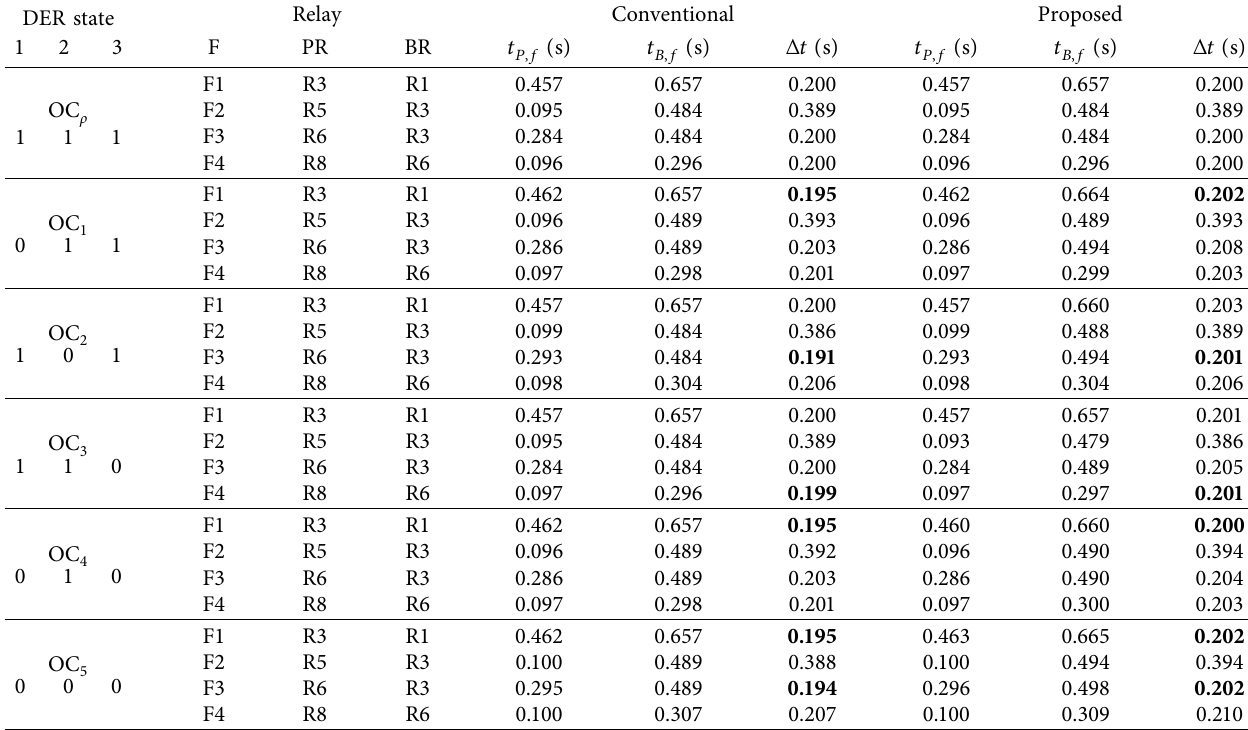
Table 3: Operating time for the conventional and proposed adaptive protection approach.